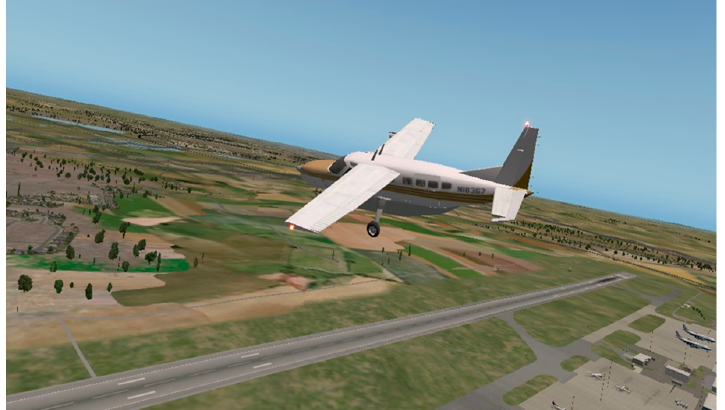
Figure 18. X-plane C208 model in simulated flight.